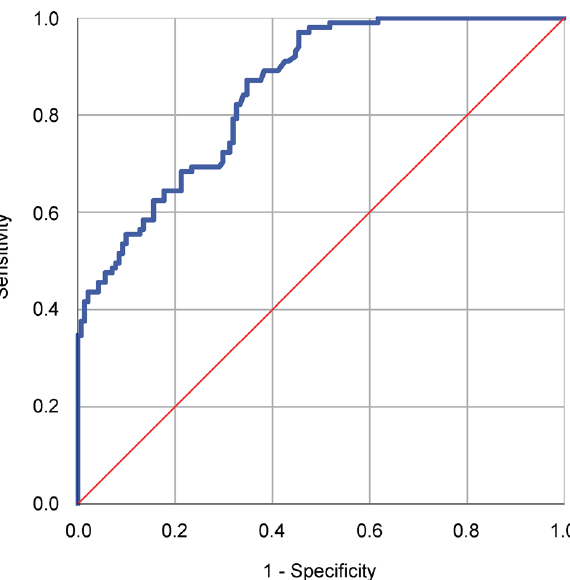
Figure 3. Forest plot of standardized mean differences (SMDs) in blood levels of macrophage migration inhibitory factor (MIF) between septic patients and patients with systemic inflammation due to noninfectious causes. CI confidence interval, SD standard deviation.